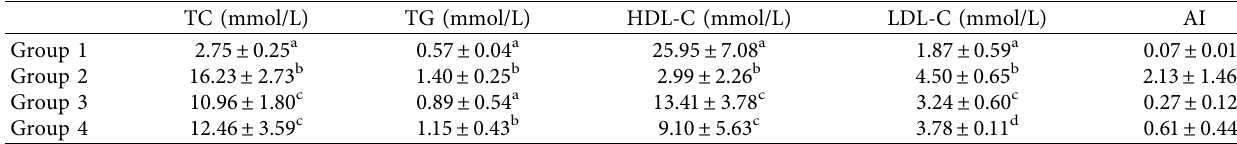
Table 2: Effects of SDF on serum lipid concentration and AI in nondiabetic and diabetic mouses.